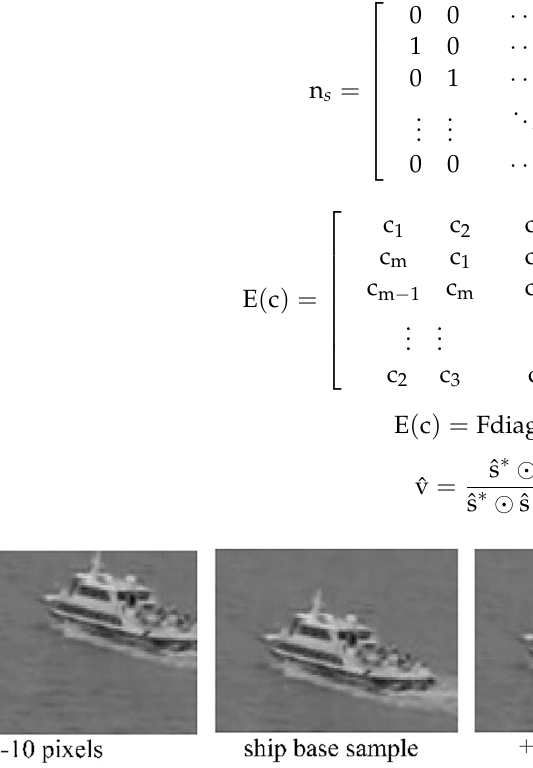
Figure 3. Ship training samples generated by the KCF cyclic-shift mechanism. The cyclic-shift ship samples are obtained by shifting starting point in both horizontal and vertical directions with certain space displacement (e.g., we minus 20 pixels from both x and y coordinates of the base ship sample without changing the width and length).